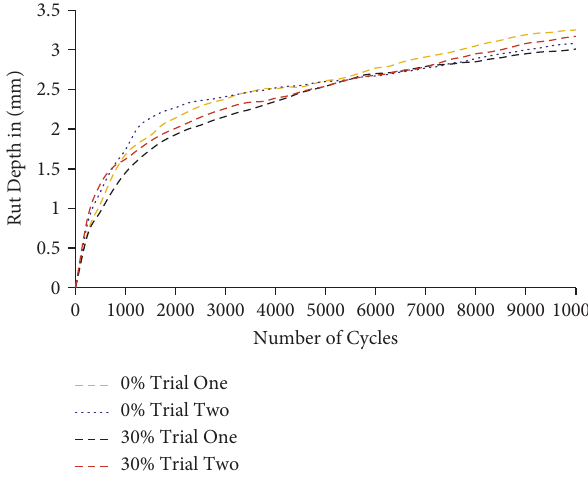
Figure 13: Rutting test result of control mix and 30% Belessa kaolin. Table 10: TSR results in the diferent proportions of Belessa kaolin and CSD.